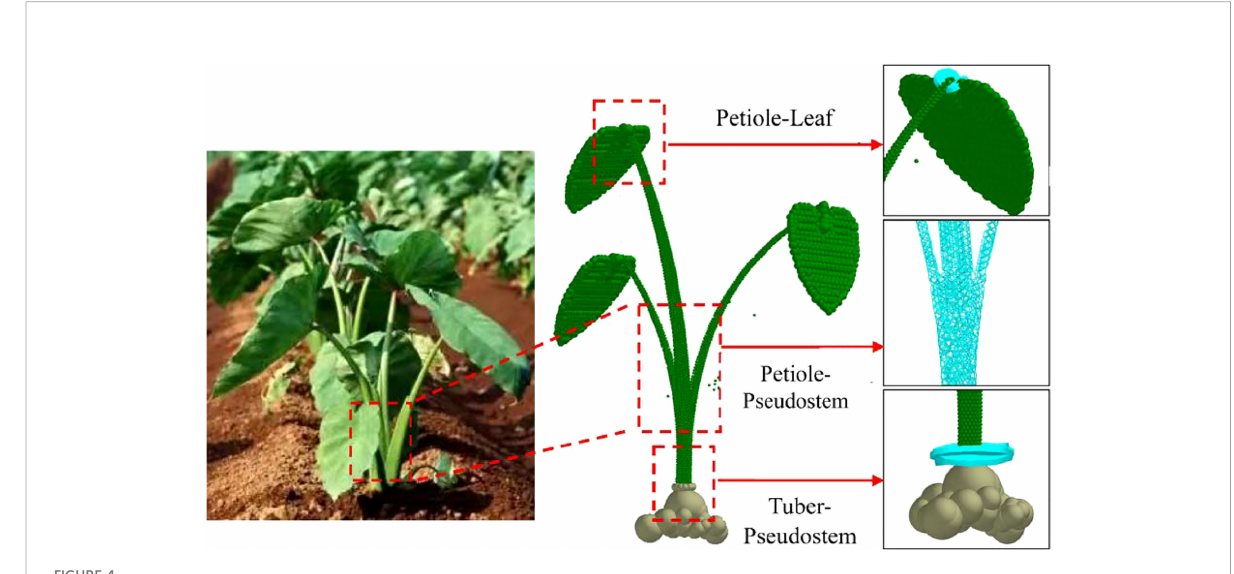
FIGURE 4 Discrete element fl exible model of taro